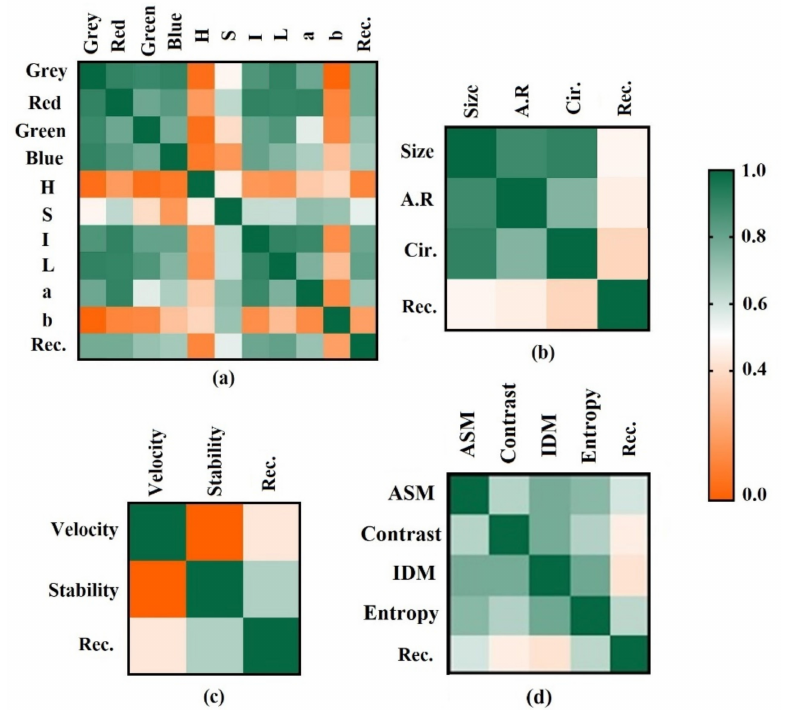
Figure 8. Pearson correlation matrix between the inputs and output. ( a ) color; ( b ) size and shape; ( c ) dynamic; ( d ) textural